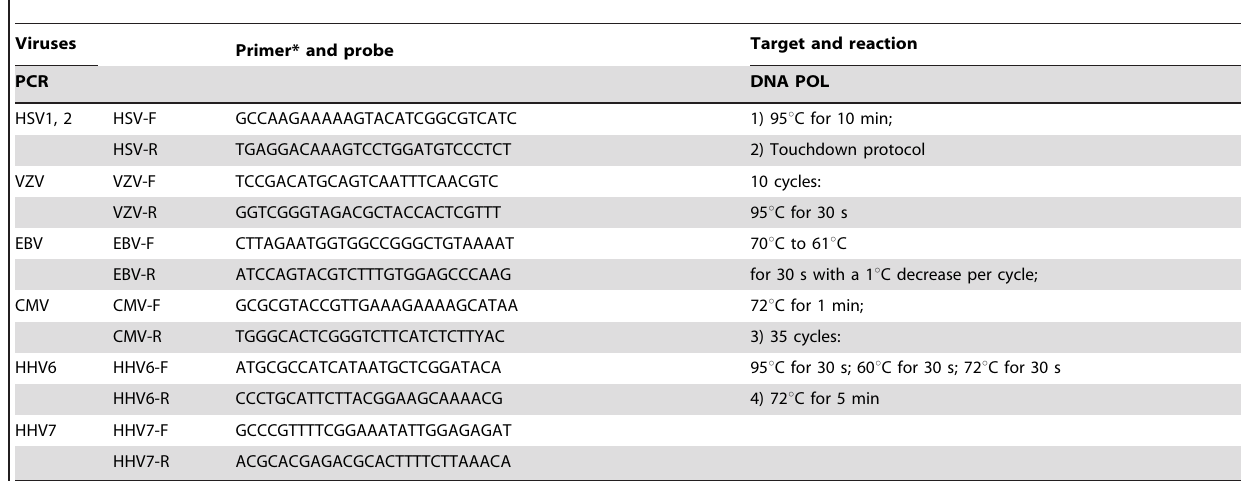
Table 1. Primers(5 9 -3 9 ) and Targets Used for the Detection of Human Herpes Viruses in the Study.